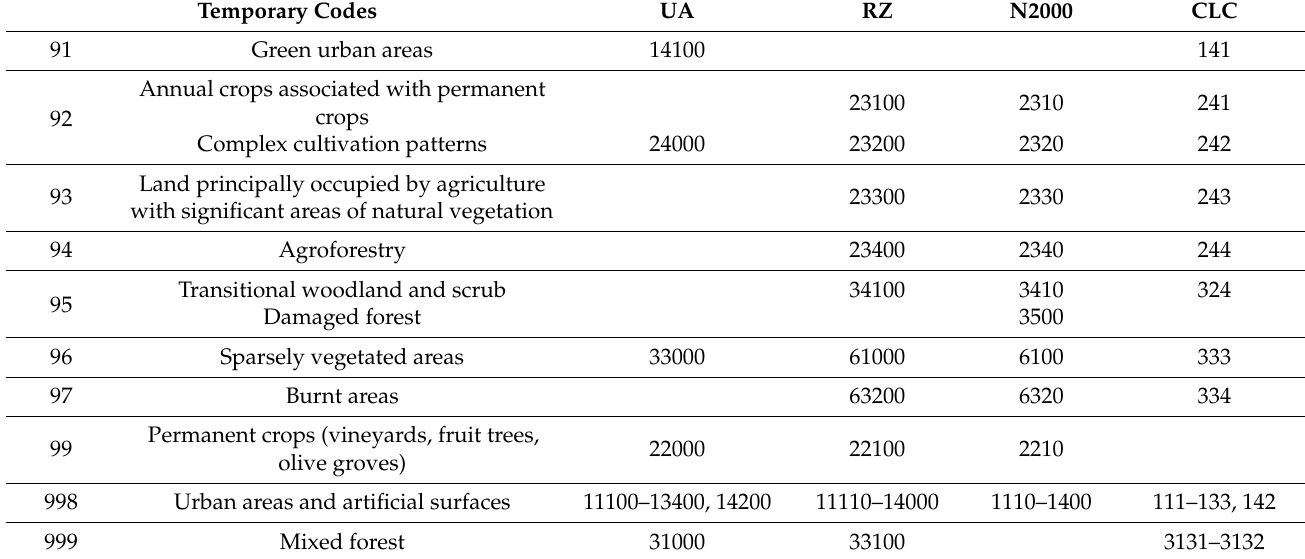
Table 4. Temporary codes for mixed land cover classes, artificial surfaces and mixed